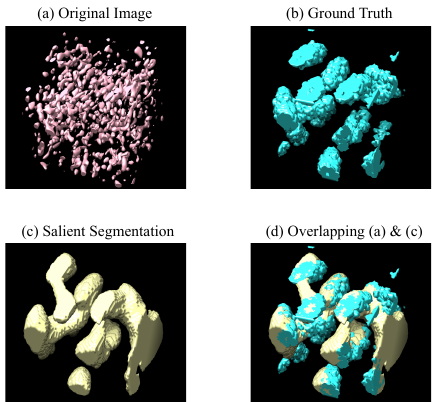
Figure 5. Visualization of 3D salient segmentation by PUB-SalNet on a 3D subvolume of size 64 × 64 × 64 from the CECT test set. The pictures are obtained using UCSF Chimera, which displays the isosurface of the four corresponding 3D images; ( a ) is the original image with a threshold of 0 ( b ) is the ground truth of macro-molecular structures ( c ) is our prediction ( d ) demonstrates that the predicted salient region greatly overlaps with the ground truth macro-molecular structure.